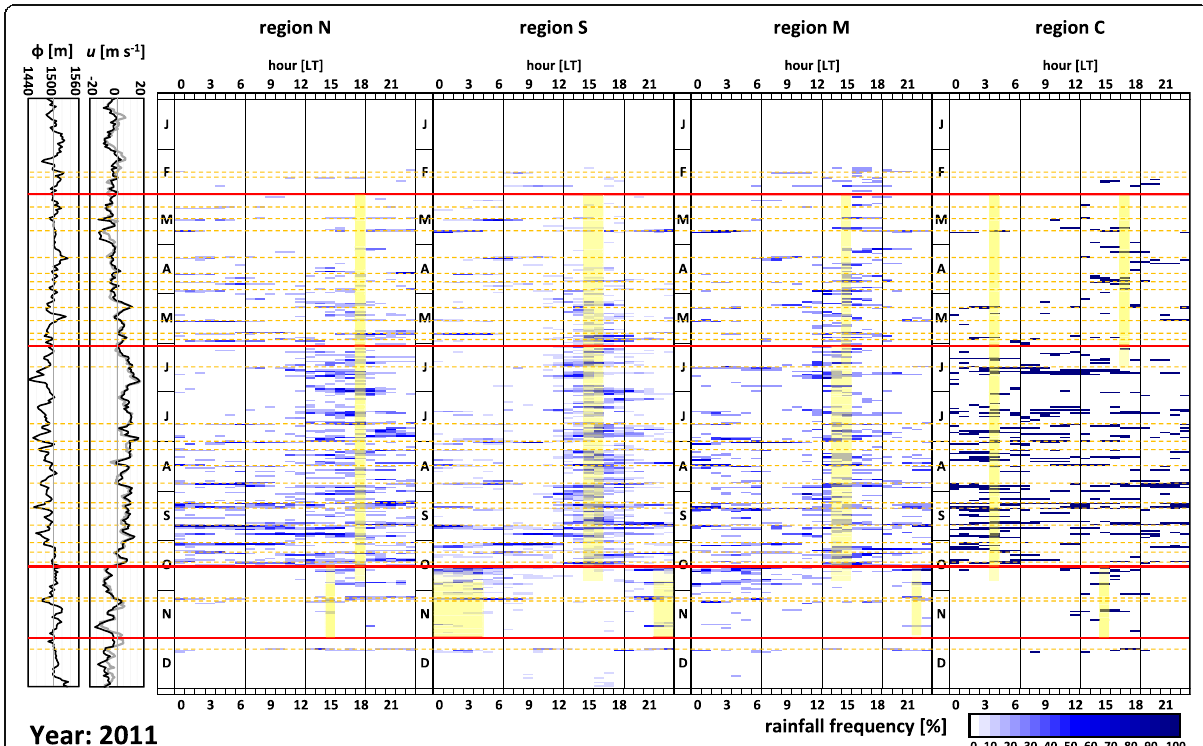
Fig. 7 Diurnal pattern of rainfall frequency for each region N, S, M, and C as the date – hour cross-section in 2011. The percentage of the number of “ rainy ” stations against the total number of stations in each region is shown with a blue shade. At region C, there is only one gauge, and thus the percentage is either 0 or 100. The horizontal red lines indicate 1 March, the onset and withdrawal dates of the summer monsoon season, and 30 November. The vertical yellow shades indicate hours with peak rainfall frequency in each season in each region, whereas the horizontal orange broken lines indicate days with prominent rainfall with no diurnal cycle or in different hours. The geopotential height ( Φ ) at 850 hPa and zonal winds ( u ) at 700 hPa (gray line) and 850 hPa (black line) as the areal averages over Cambodia (102 – 108°E and 10 – 15°N) at 7:00 LT (0:00 UTC) from JRA-55 are also shown for each day in the left